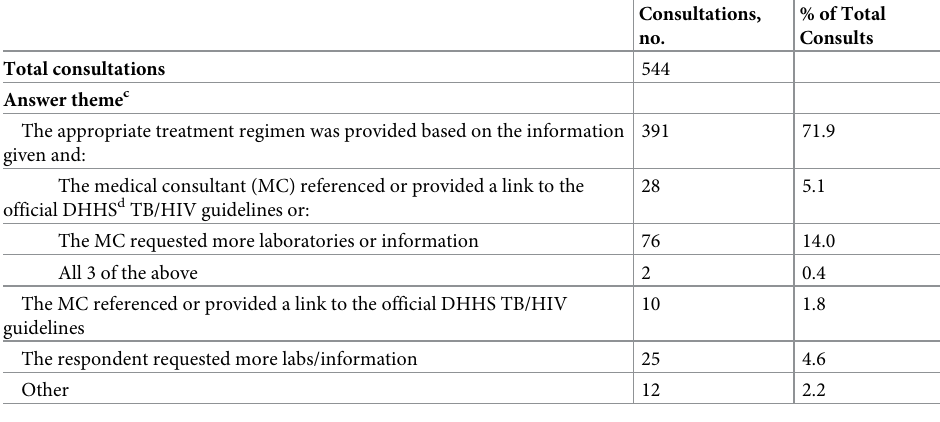
Table 4. Summary of main answer themes among TB/HIV consultations a provided by all Regional Training And Medical Consultation Centers (RTMCCs) b ,